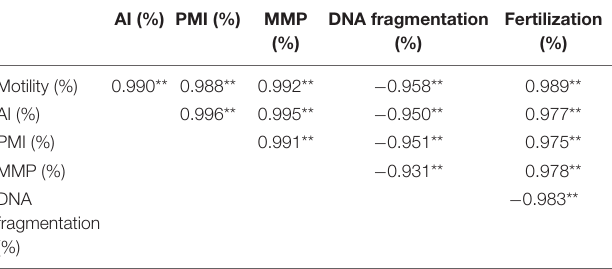
TABLE 6 | Correlation coefficient ( r ) between sperm quality parameters of Pacific abalone, H. discus hannai . AI (%) PMI (%) MMP DNA fragmentation (%)